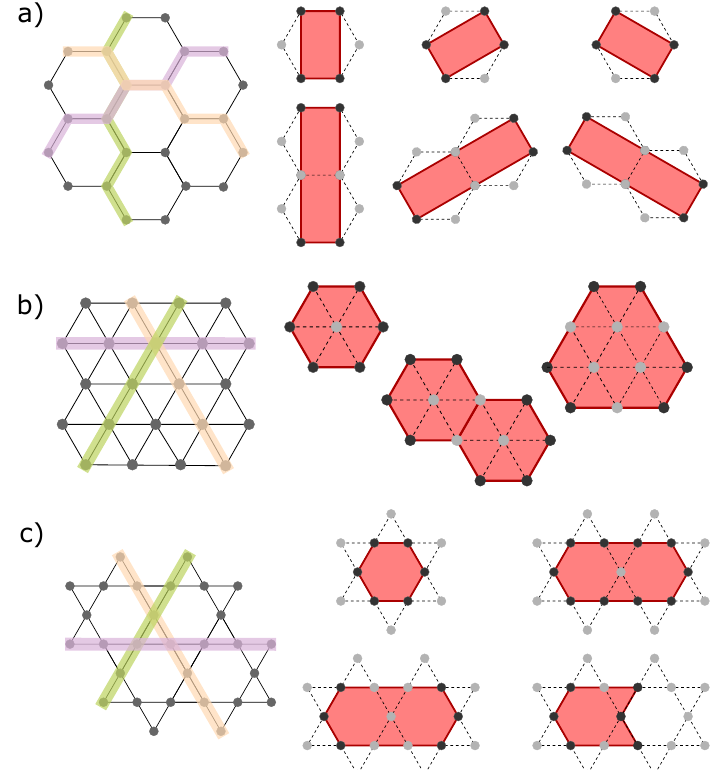
Figure 20: Ring-exchange terms depicted with red solid figures that preserve sub- system symmetries with support on 1D submanifolds depicted with yellow, purple and green lines, on (a) honeycomb, (b) triangular, (c) kagome lattices. Only spins colored in black take part in the ring-exchange, while light-grey spins do not. In addition to the most local interactions, several longer-range examples are